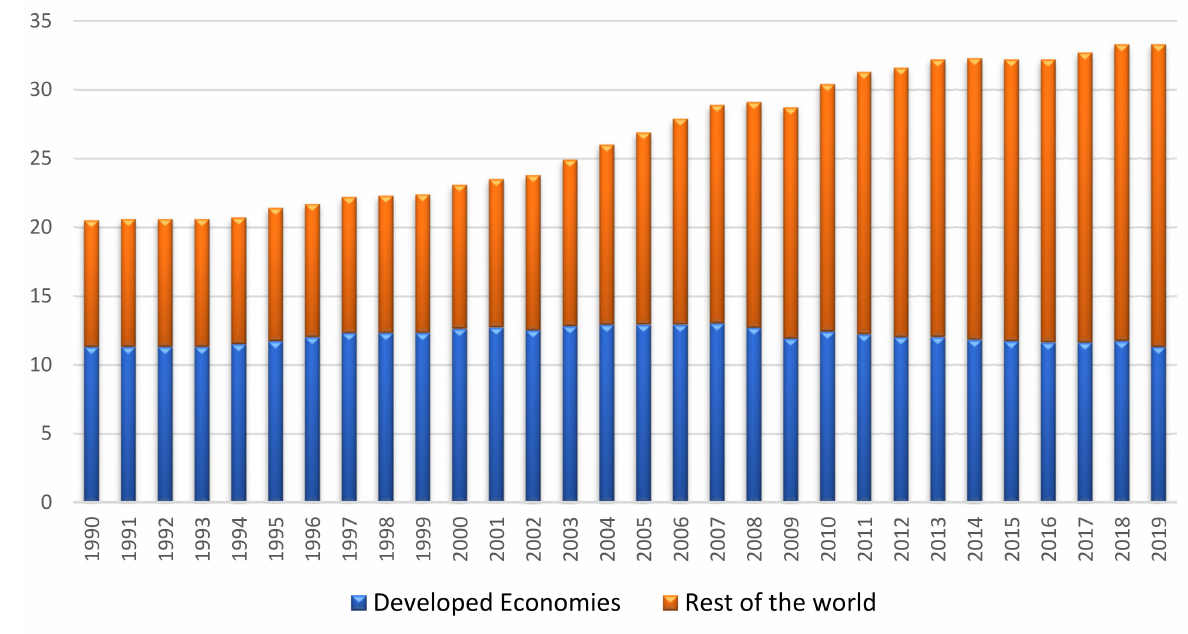
Figure 1. CO 2 emissions for power generation in Giga Tons (Source: IEA (2020), Global CO2 emissions in 2019, IEA, Paris https://www.iea.org/articles/global-co2-emissions-in-2019 as modified by the authors. All rights reserved)